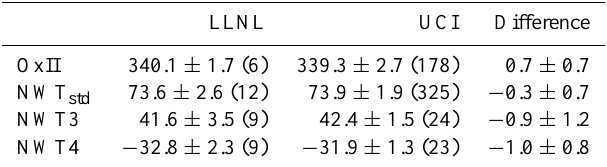
Table 1. Mean 1 14 C values of secondary standard materials mea- sured at CAMS for this experiment, and long-term measurements made at UCI since 2002. Values are reported as the mean and one- sigma repeatability of each dataset, with the number of measured targets given in